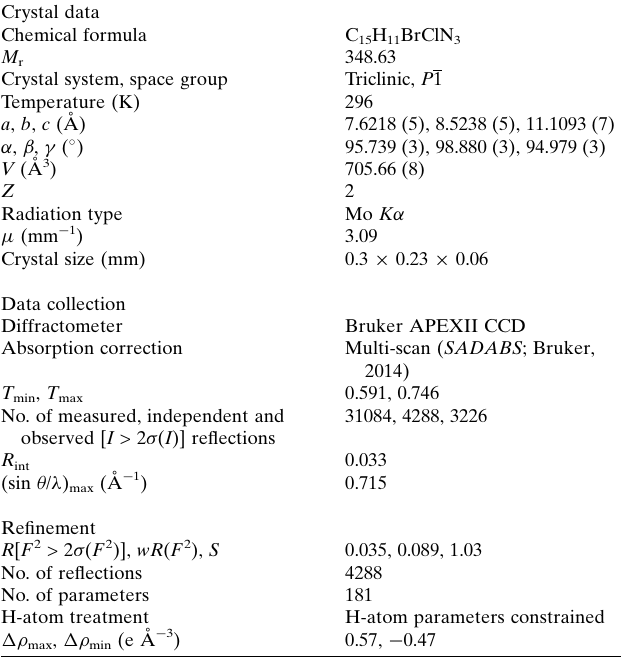
Crystal data Chemical